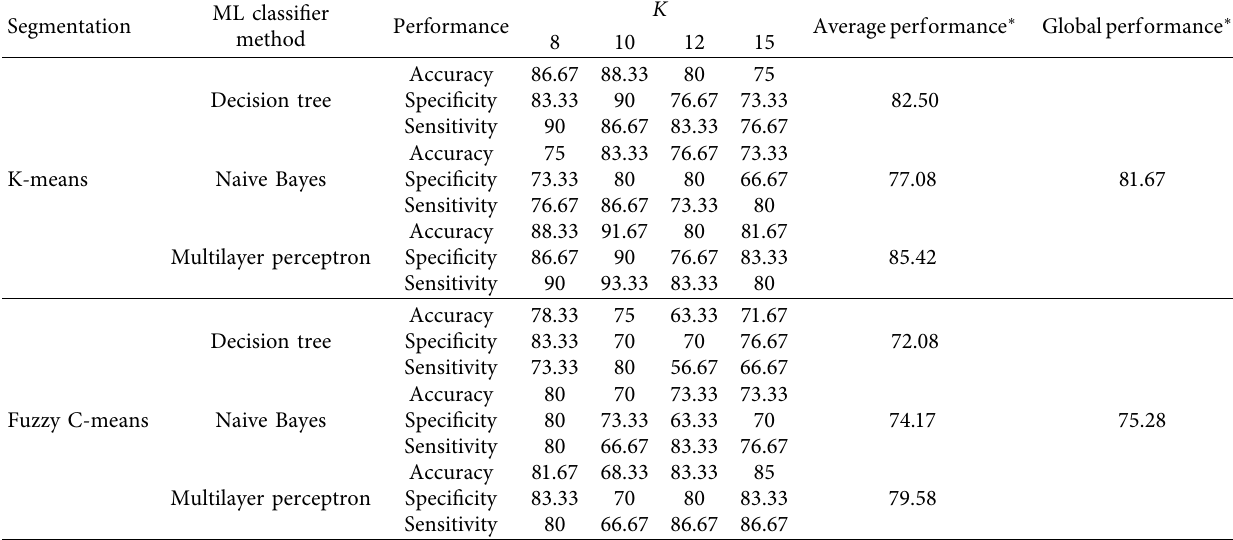
Table 3: Training performance of K - means and Fuzzy C-means classifcation.